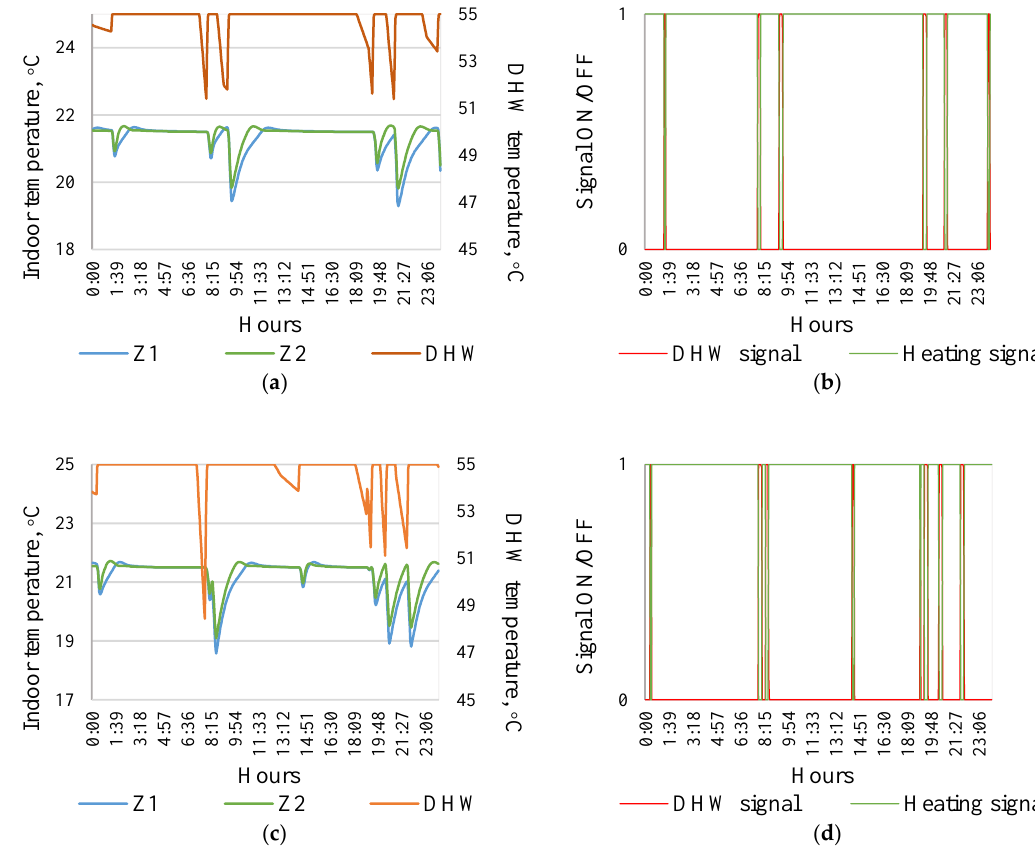
Figure 13. Building parameters followed the old building regulation of 1976 ( a ) indoor temperature and DHW supply temperature for an old single-family house occupied by four people, ( b ) heating and DHW signals for an old single-family house occupied by four people, ( c ) indoor temperature and DHW supply temperature an old single-family house occupied by six people, ( d ) heating and DHW signals for an old single-family house occupied by six people.